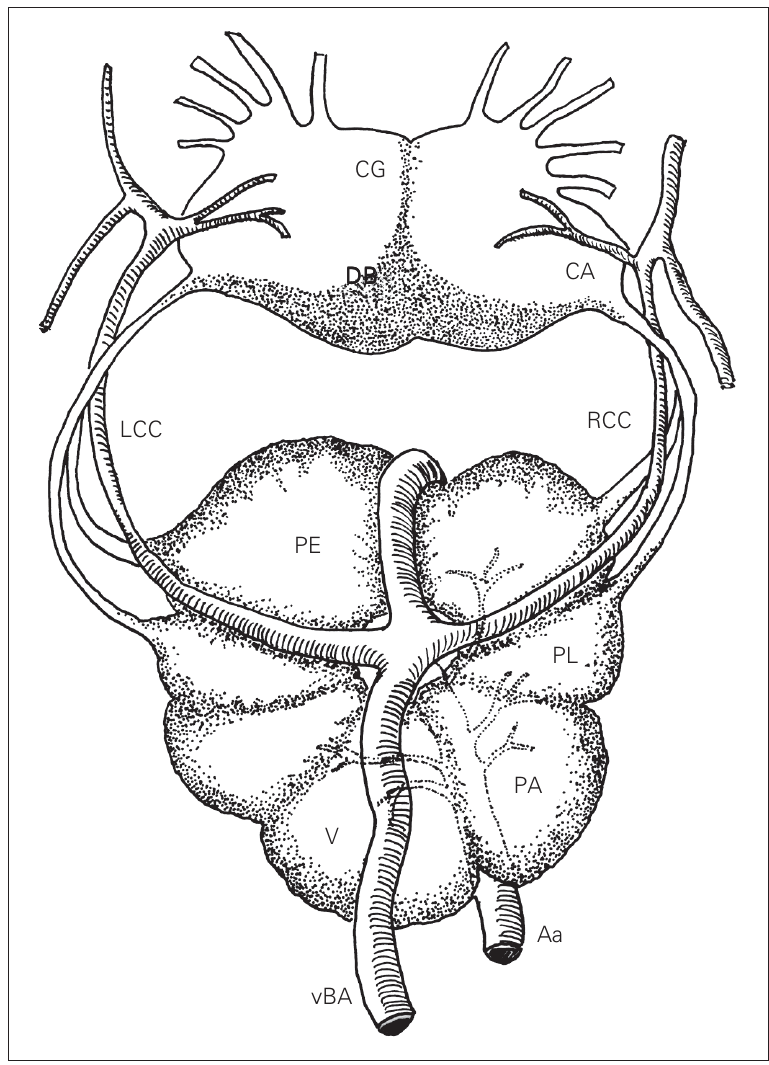
Figure 1. Schematic representation of the periesophageal ring and the vascular supply of the different central nervous ganglia in a posterodorsal view. The anterior aorta in its run ventral to the subesophageal ganglia is represented by a discontinuous line. Aa, anterior aorta; CA, cerebral artery; CG, cerebral ganglion; DB, dorsal body gland; LCC, left cervical- cephalic artery; PA, parietal ganglion; PE, pedal ganglion; PL, pleural ganglion; RCC, right cervical-cephalic artery; V, visceral ganglion; vBA, ventral-buccal artery.